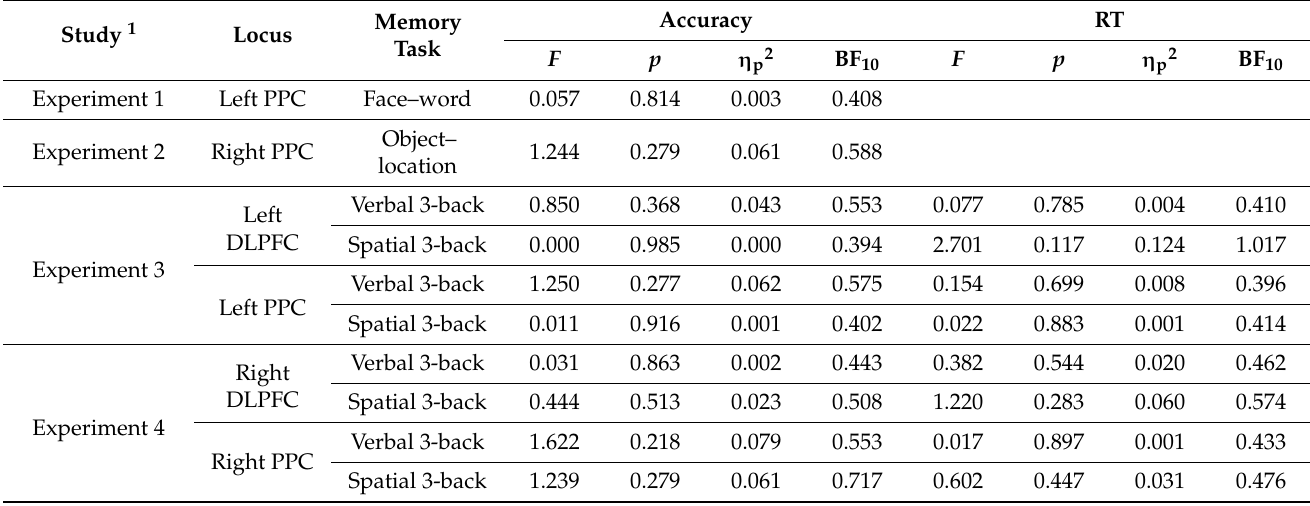
Table 3. The interaction effects between correct intervention guessing (i.e., sham guessed correctly or not) and stimulation condition (real vs. sham) for the outcome measures (accuracy and